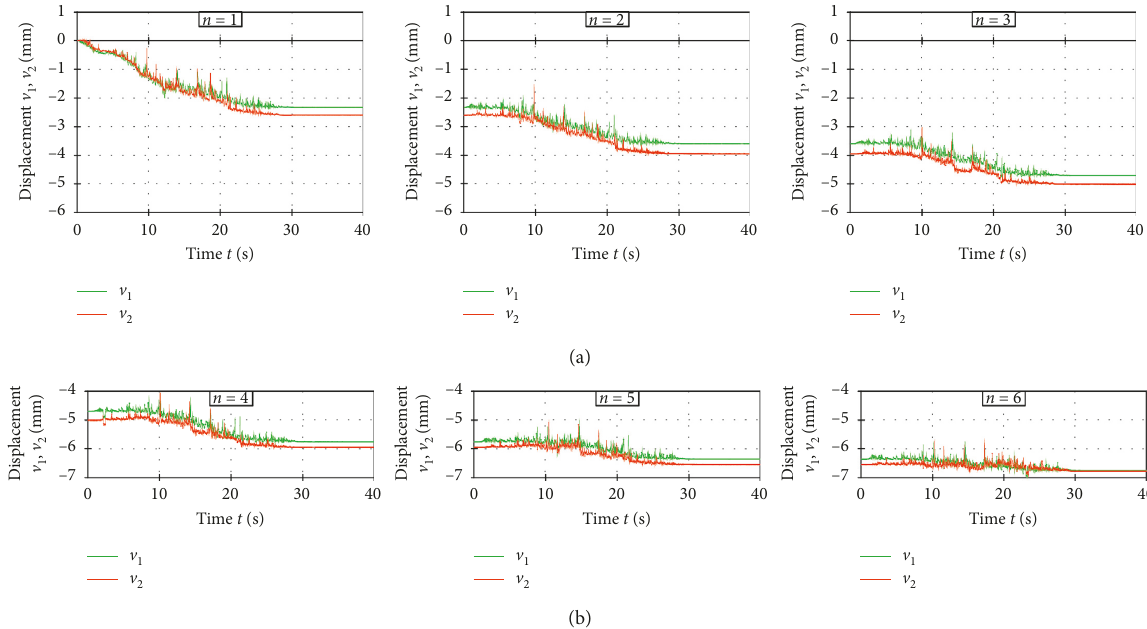
Figure 33: Vertical displacements v and v for repeated excitation 1 2 (vii) For the effect of successive strong earthquake repetition (six consecutive repeats of two different types of earthquakes with PGA � 0.6 g), the con- ducted tests have shown that large permanent horizontal building displacement can occur (up to 3.5 times the initial displacement) and increase the initial building horizontal acceleration (up to 20%), i.e., reduction of aseismic layer efficiency.